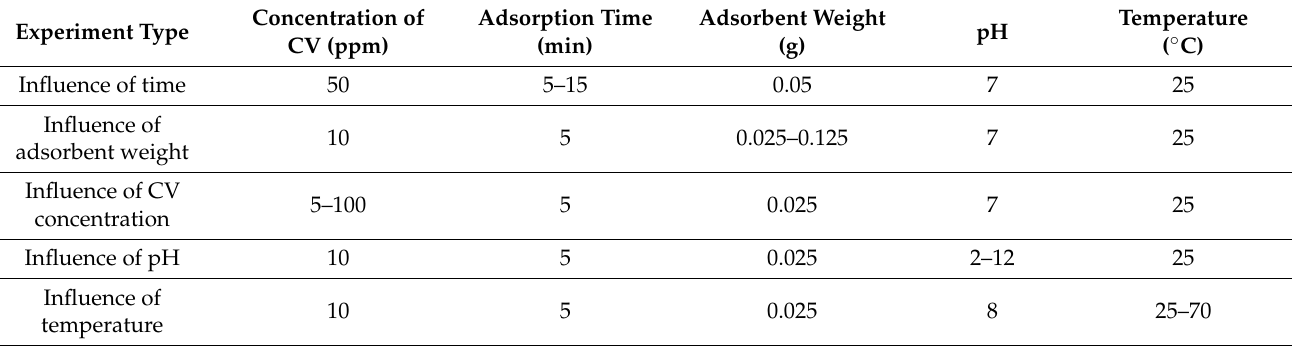
Table 1. The experimental conditions for adsorption of CV using